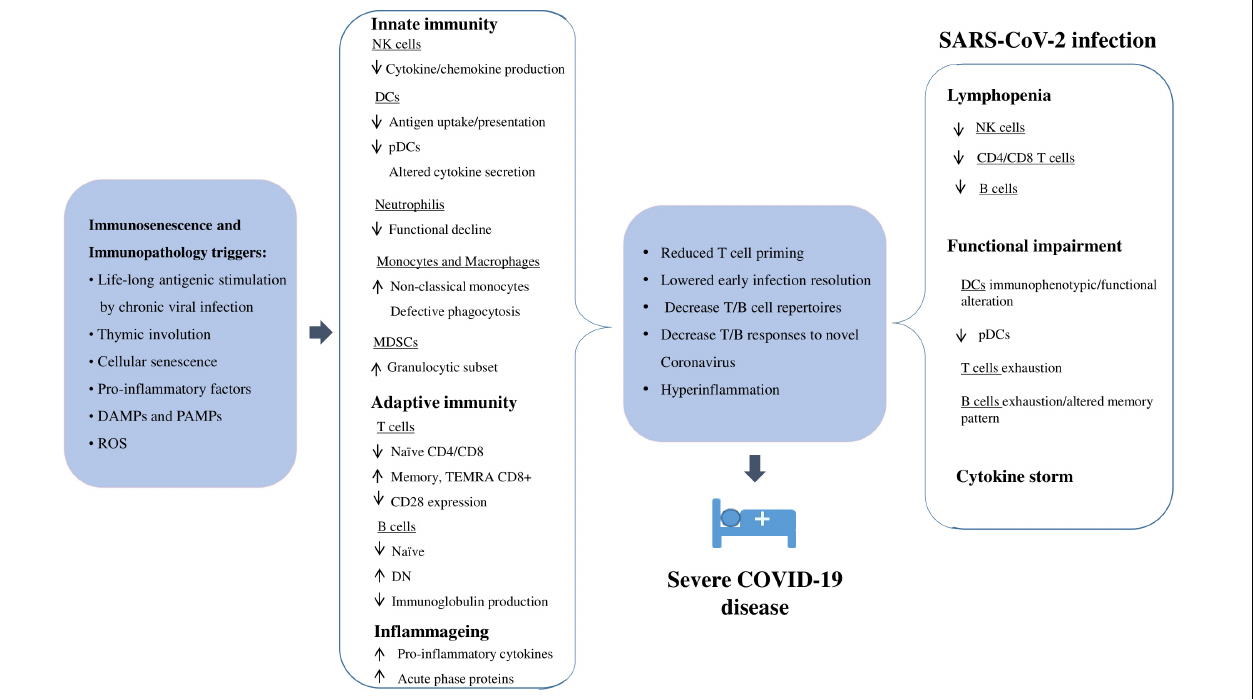
FIGURE 1 | A schematic view of how immunopathology and immunosenescence could contribute to severe COVID-19 in older people. PAMPs, pathogen associated molecular patterns; ROS, reactive oxygen species. See text for other